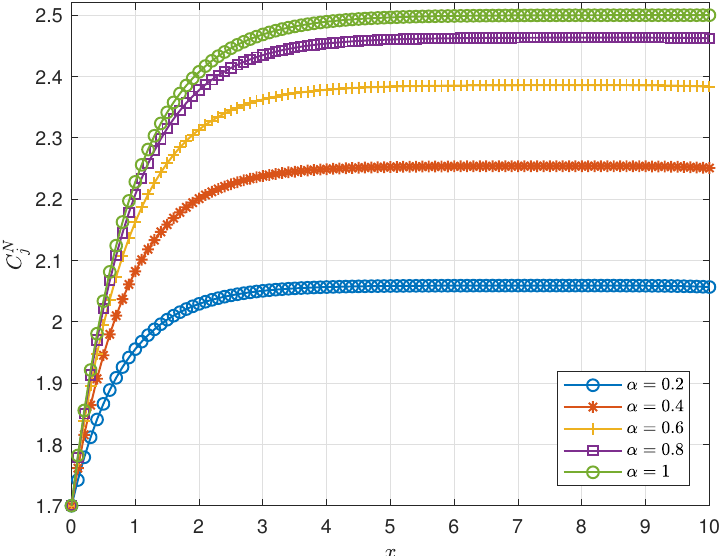
Figure 2. Numerical solution at different time steps obtained with α = 0.5.